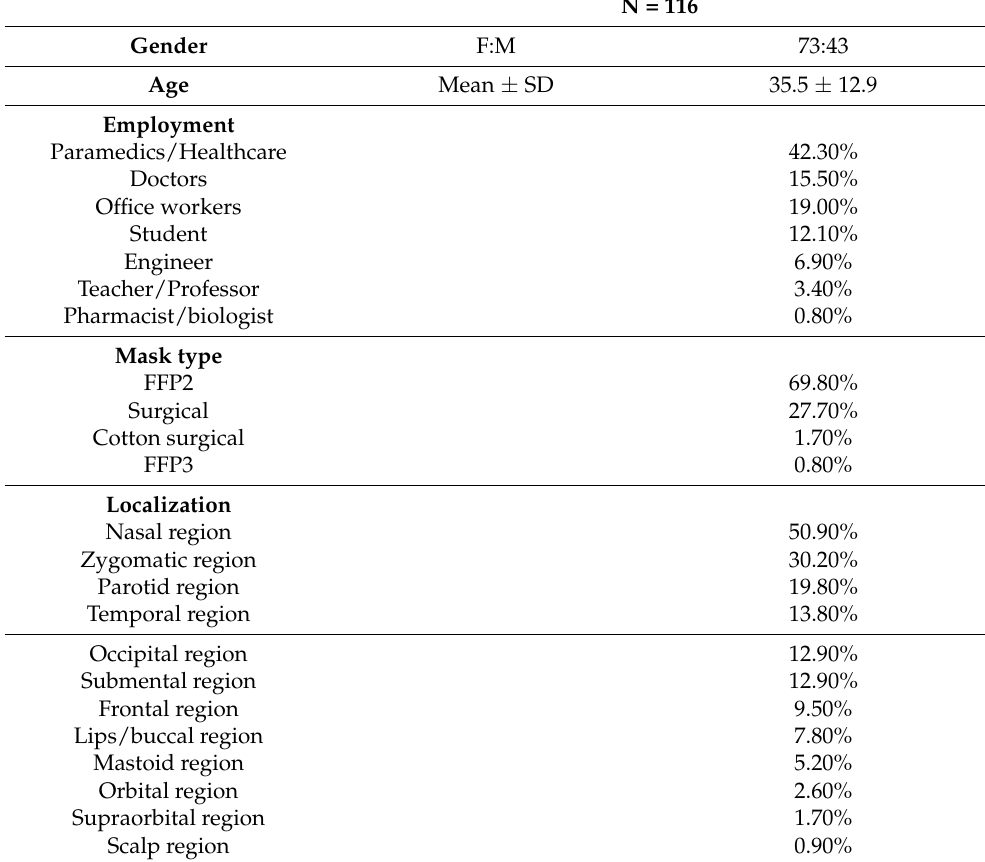
Table 1. Characteristics of subjects and localization of head and/or facial neuropathic pain